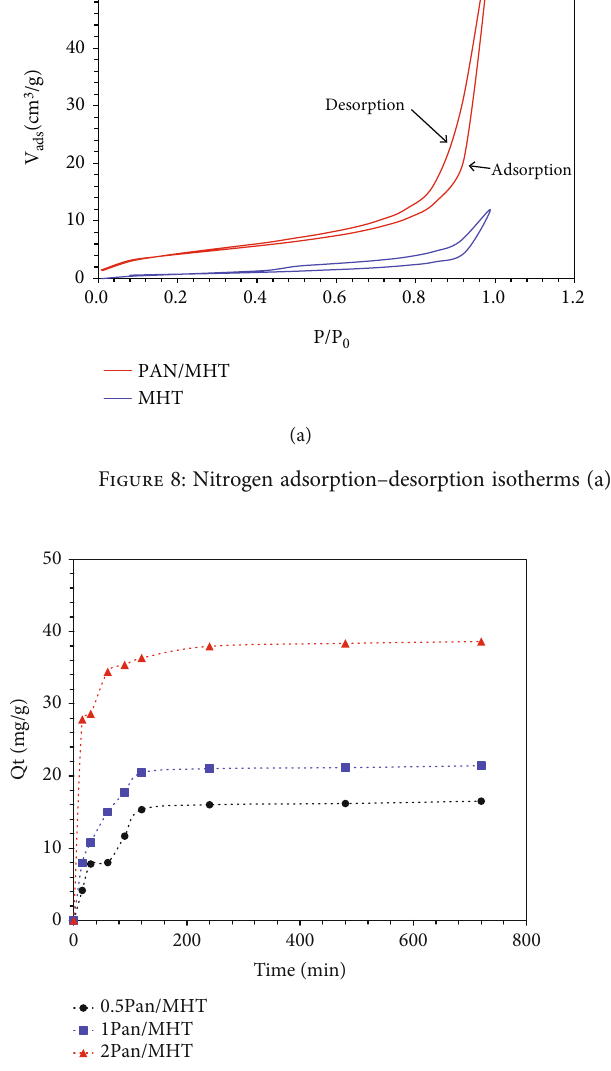
Figure 9: E ff ect of contact time on MO adsorption onto 0.5 Pan/ MHT, 1 Pan/MHT, and 2